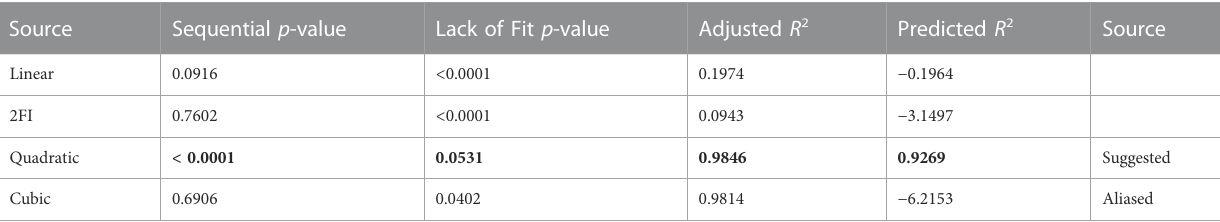
Bold values means the values were